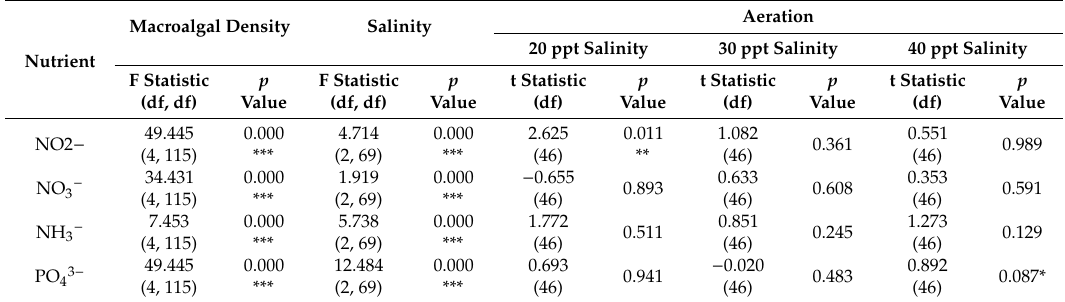
Table 1. ANOVA for di ff erent macroalgal density and salinity levels and two-sample t test for aeration. Macroalgal Density Nutrient